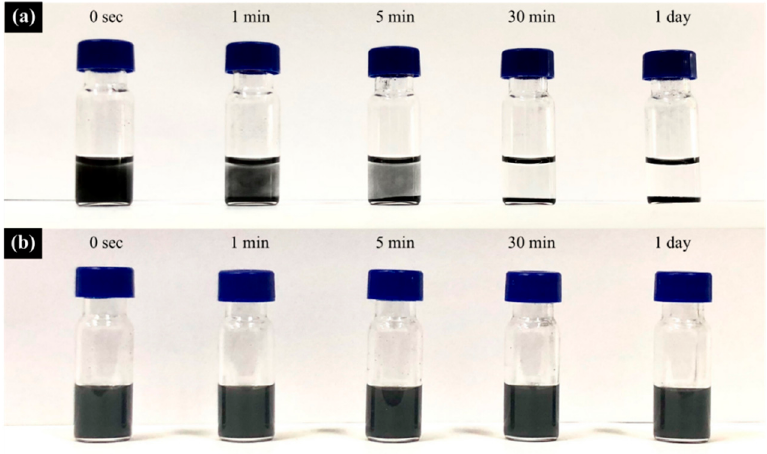
Figure 4. Photographs of ( a ) pristine graphene solutions and ( b ) PEBF/graphene solutions stored for different times.